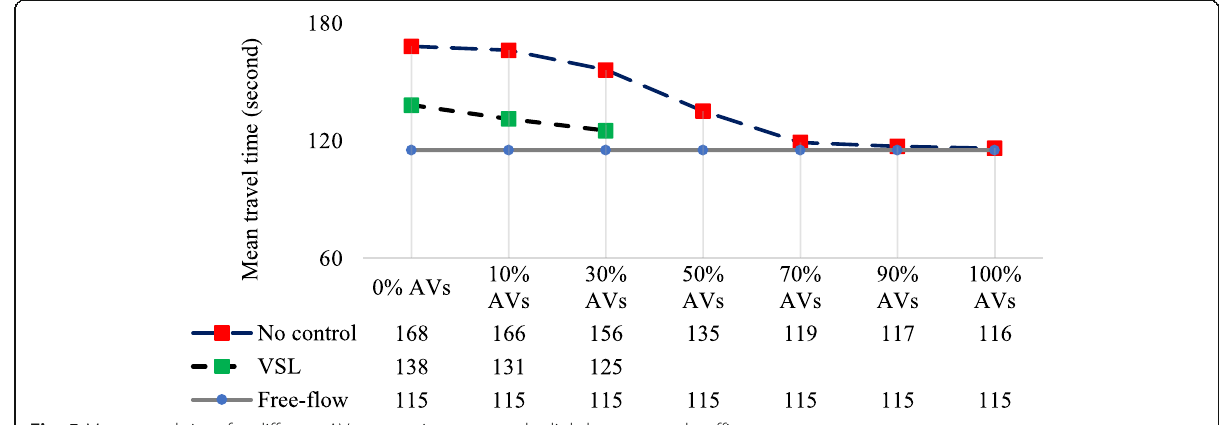
Fig. 5 Mean travel time for different AV penetration rates under lightly congested traffic